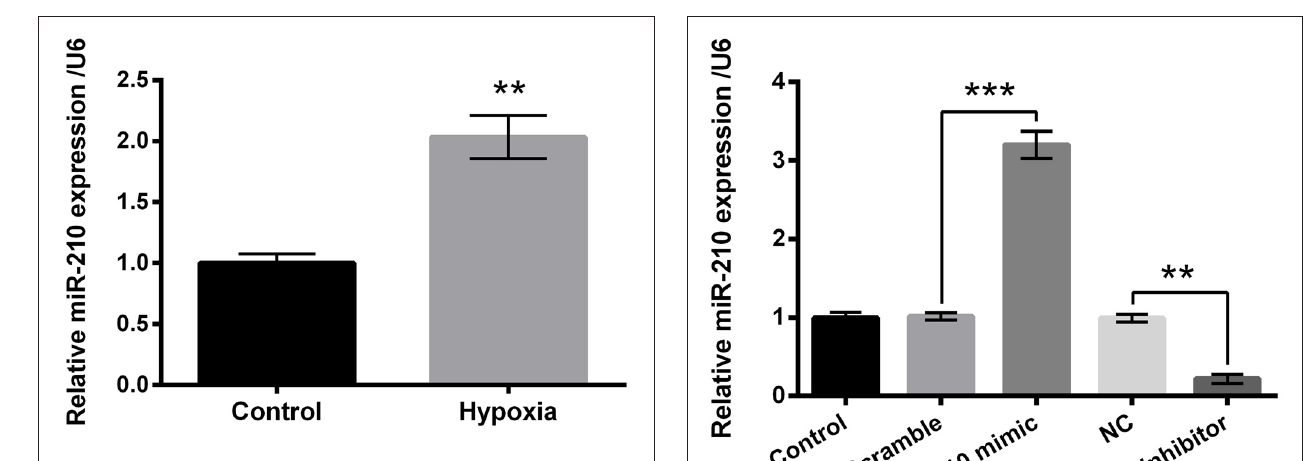
FIGURE 2 | Expression of microRNA (miR)-210 in hypoxia-treated PC-12 cells. Data presented are the mean ± SEM of at least three independent experiments. ∗∗ P < 0.01.